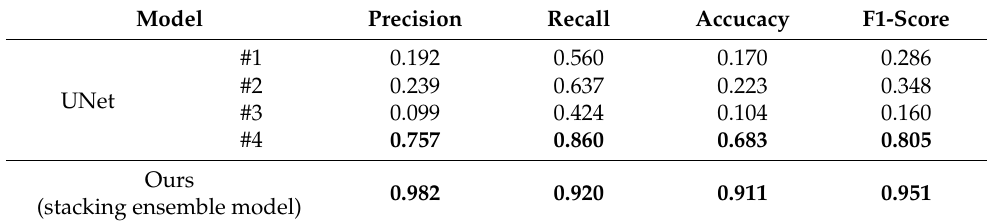
Figure 14. Images of concrete surface and corresponding labeled cracks.